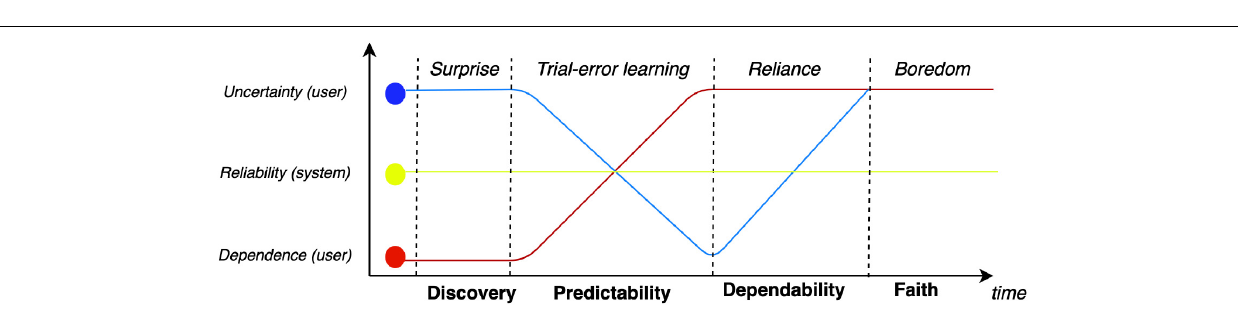
FIGURE 4 | Dynamics of trust over time–with four phases from discovery to faith: for a consistently reliable system, dependence (i.e., risk) is inversely proportional to uncertainty, assessed through a cycle of trial and error, until a threshold is reached. Through cycles of trial and errors, trust gradually evolves from predictability (model) to dependability (control) to a state of faith (overreliance). Our model suggests that boredom is a marker of